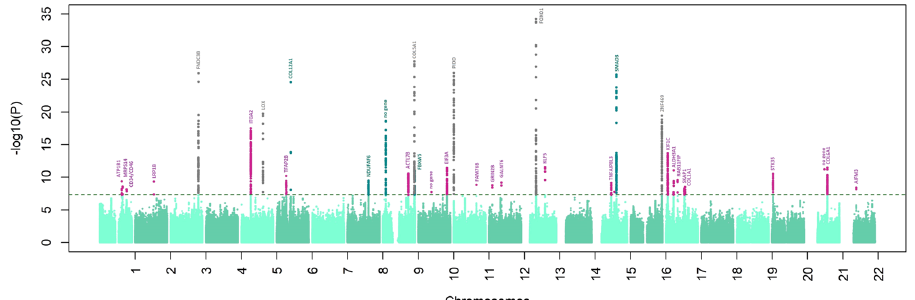
Fig. 3 An annotated Manhattan plot of the fi nal trans-ethnic meta-analysis data for all keratoconus cohorts in this study. Analyses were conducted in 4669 cases and 116,547 controls. The log10( p -value) from the fi nal meta-analysis is shown on the y-axis for all the SNPs along the different autosomes (x- axis). Novel associations for keratoconus are in pink. The names of the coding genes nearest to the most signi fi cantly associated SNPs are shown, or “ no gene ” when the association was >250kb from a coding gene. Different colors are used for genetic loci and genes that to our knowledge, were previously associated with CCT (dark green) keratoconus (dark fi brillar (XII) structures 26 , implicating impaired cohesion of the collagen matrix in the pathogenesis of keratoconus. Association was also found for rs35523808 (p.Glu2160Val, p = 2.90 × 10 − 25 ), a missense and potentially deleterious variant within COL12A1 (Table 1, Supplementary Data 5). Collagen XII is localized in Bowman layer and the inter fi brillar matrix of the corneal stroma, where it regulates the organization and mechanical properties of collagen fi brils 27 . We found signi fi cant association within the COL6A1 gene (rs142493024, p = 9.07 × 10 − 12 ). The collagen VI protein is localized to corneal stroma fi laments where it contributes to the integrity of the extracellular matrix 28 . Other associations were for COL1A1 (rs2075556, p = 3.35 × 10 − 09 ) and COL5A1 (rs3118518, p = 1.83 × 10 − 28 ). Collagen V is a regulator